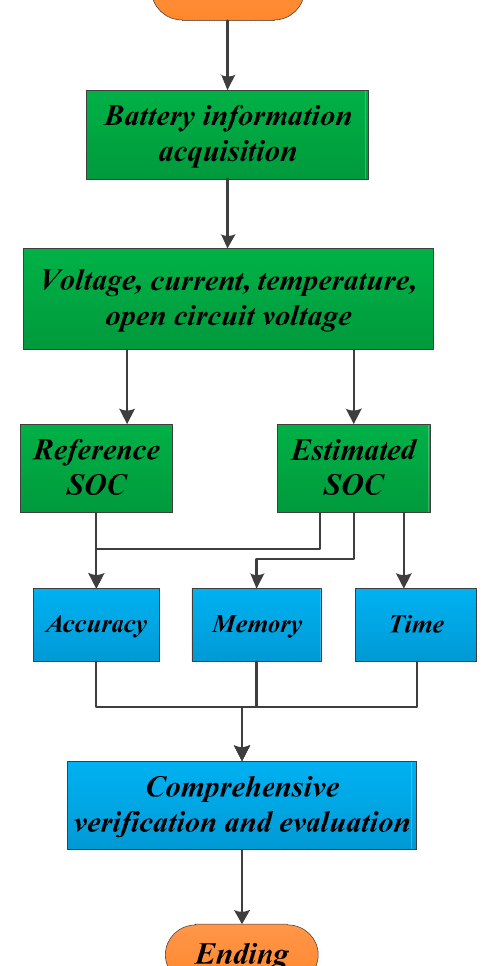
Figure 10. Verification and evaluation process of the SOC estimation method.